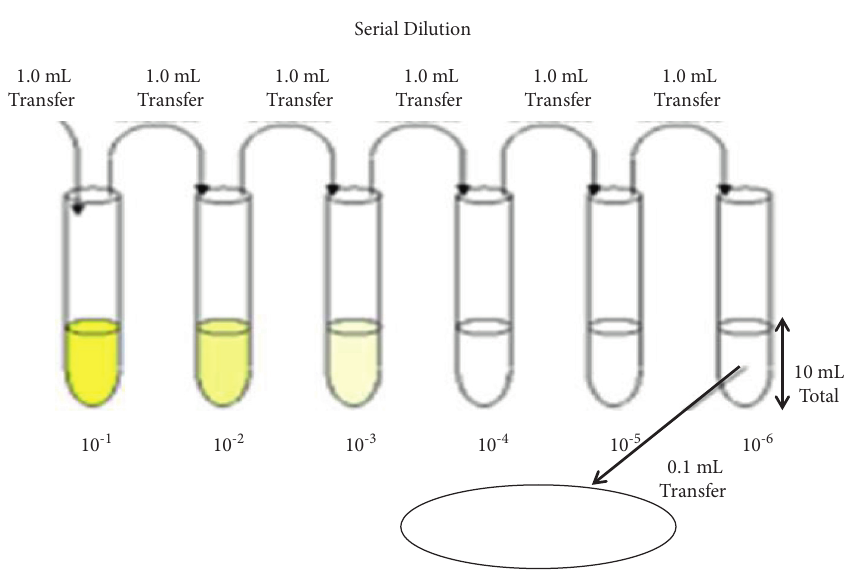
Figure 5: Bacterial solution dilution